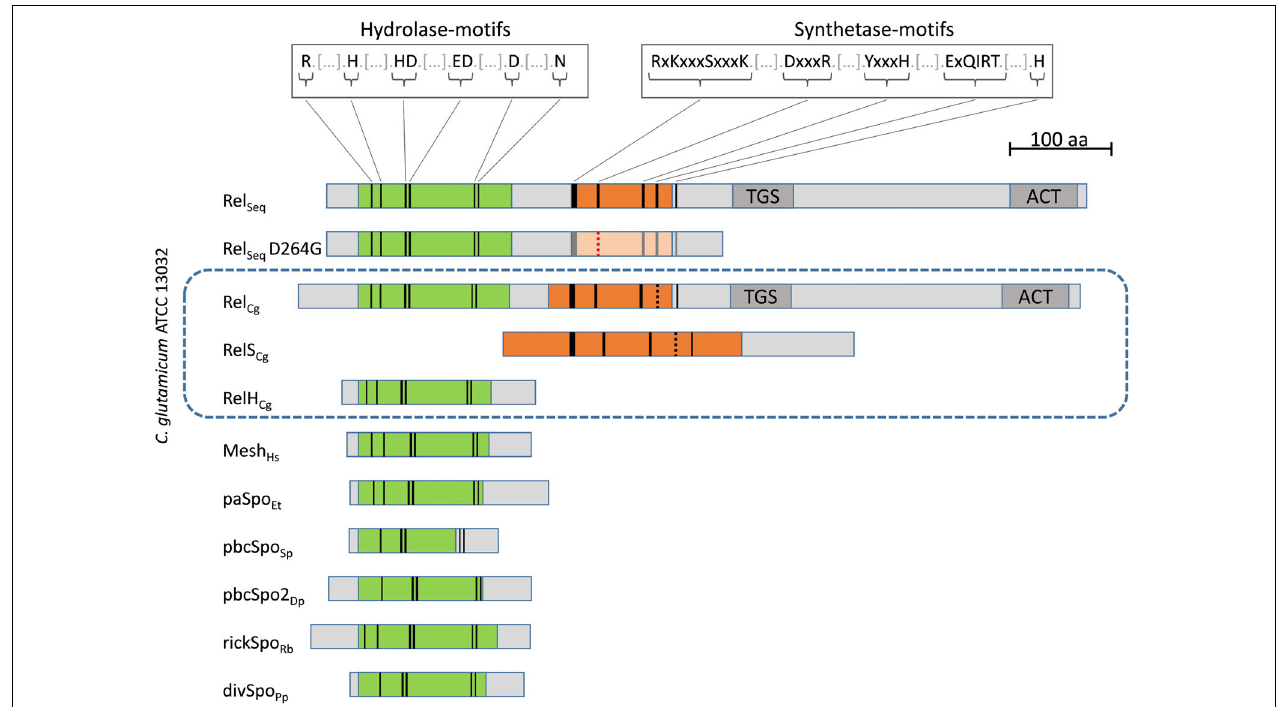
FIGURE 1 | Comparative structural analysis of enzymes involved in (pp)pGpp metabolism. True-to-scale representation of domain architecture and conserved sequence motives of stringent response associated enzymes of C. glutamicum ATCC 13032 (enclosed by dashed blue lines) and further selected species. These include the native Rel enzyme of Streptococcus equisimilis Rel Seq , as well as the shortened and only hydrolytically active variant Rel Seq D264G (Hogg et al., 2004; Sun et al., 2010) and representatives of the six other SAH subgroups (Atkinson et al., 2011): Mesh ( Homo sapiens ), paSpo ( Erwinia tasmaniensis ), pbcSpo ( S. pneumoniae ), pbcSpo2 ( Desulfotalea psychrophila ), rickSpo ( Rickettsia bellii ), and divSpo ( Photobacterium profundum ). Hydrolase domain HD4 (pfam13328) and ppGpp synthetase catalytic domain YjbM (COG2357) are indicated in green and orange, respectively. Additional C-terminal elements of long RSH enzymes, which are likely to have regulatory functions and are classified as TGS (ThrRS, GTPase, and SpoT) and ACT (aspartate kinase, chorismate mutase and TyrA) domains (Wolf et al., 1999; Chipman and Shaanan, 2001), are also indicated. Matches with conserved synthetase and hydrolase motifs are represented by black lines (Bag et al., 2014; Steinchen and Bange, 2016). Minor deviations from the conserved sequence motifs are shown by dashed black lines. The amino acid exchange of the protein Rel Seq D264G is represented by a red dashed line and the resulting non-functional YjbM domain is faded